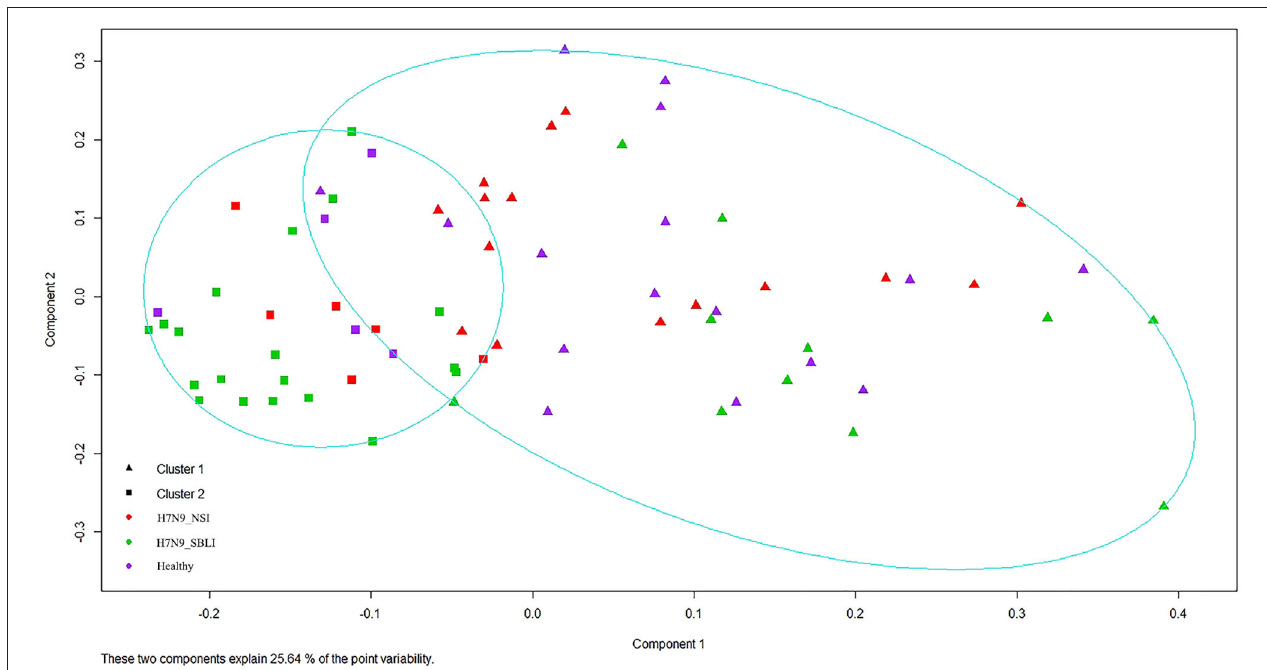
FIGURE 1 | All the 72 oropharyngeal (OP) microbiotas were clustered into two clusters by Partition Around Medoids (PAM) clustering analysis.